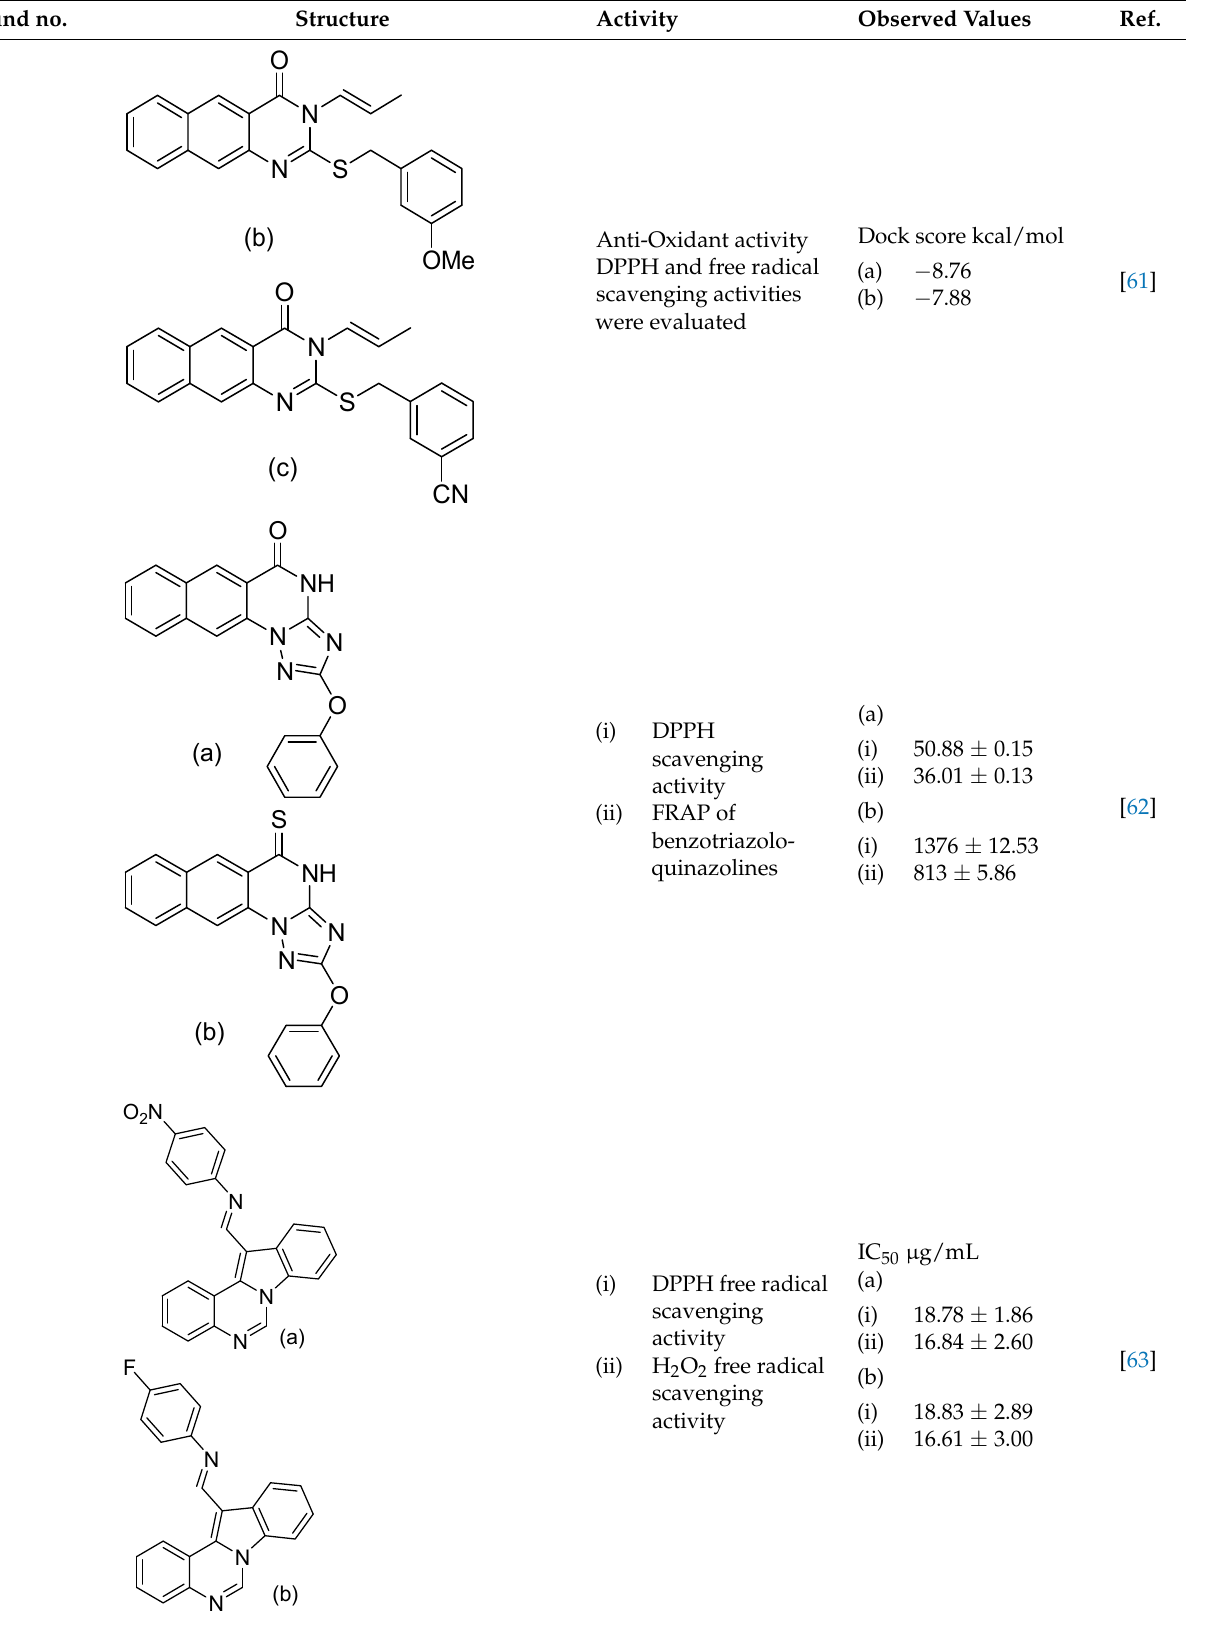
Table 6. Antioxidant activity of quinazoline derivatives. Compound no.